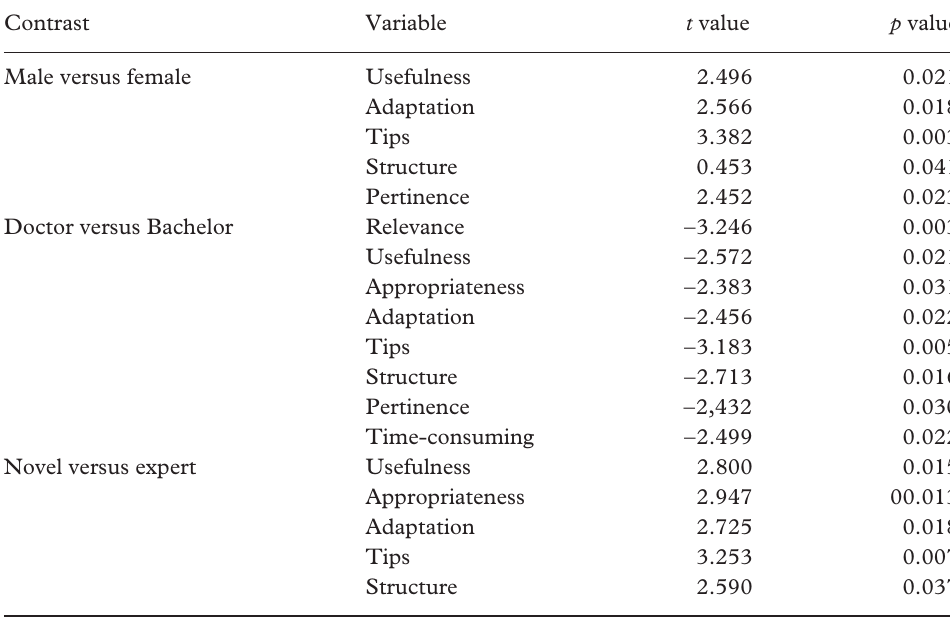
Table 3. Significant t -test results for demographic and academic factor comparisons Contrast